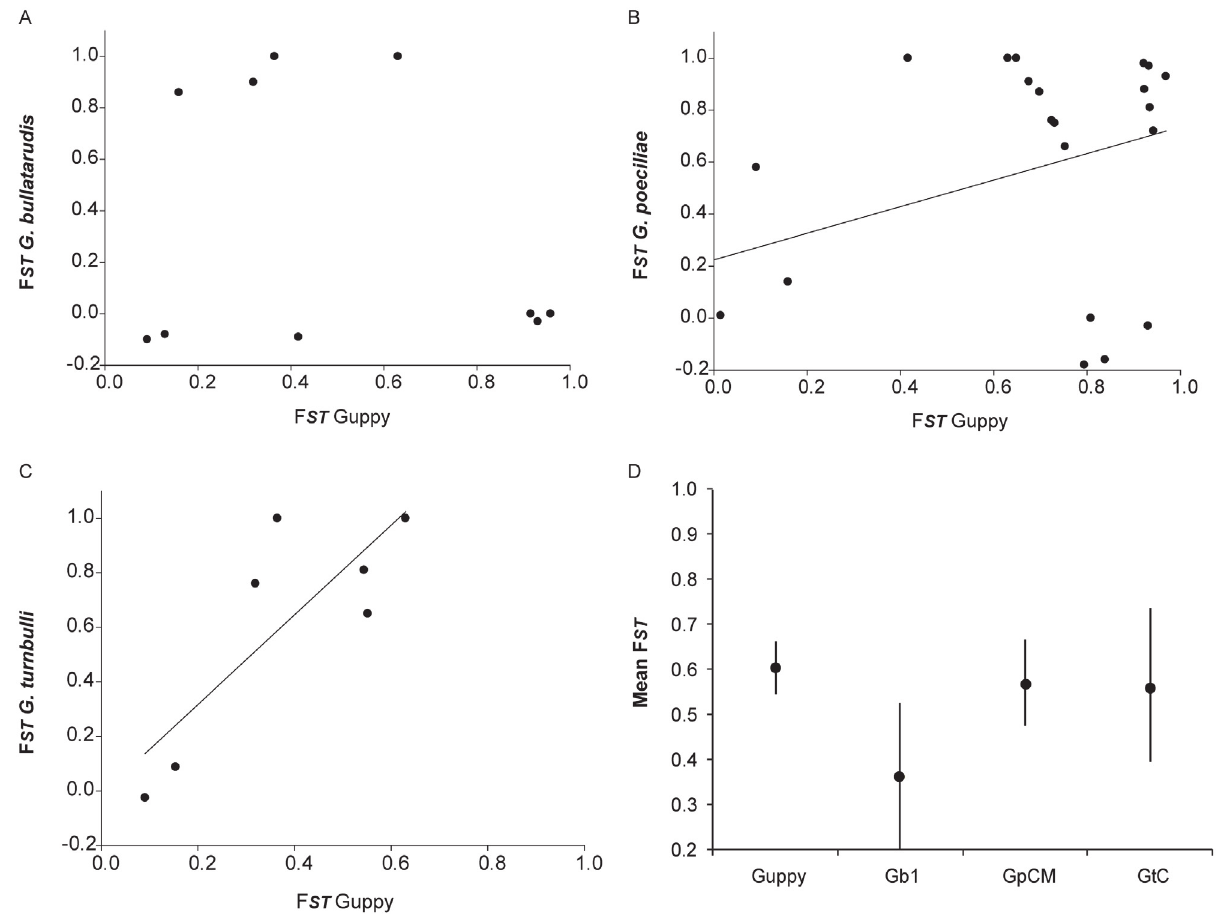
Figure 3. F ST plots for guppy host vs parasites of (A) lineage Gb1 of Gyrodactylus bullatarudis , (B) lineage GpCM of G. poeciliae , and (C) lineage GtC of G. turnbulli . Pearson ’ s correlation depicted if apparent. Additionally, mean F ST and SEM (standard error of the mean) are depicted in (D) for the guppy host and all 3